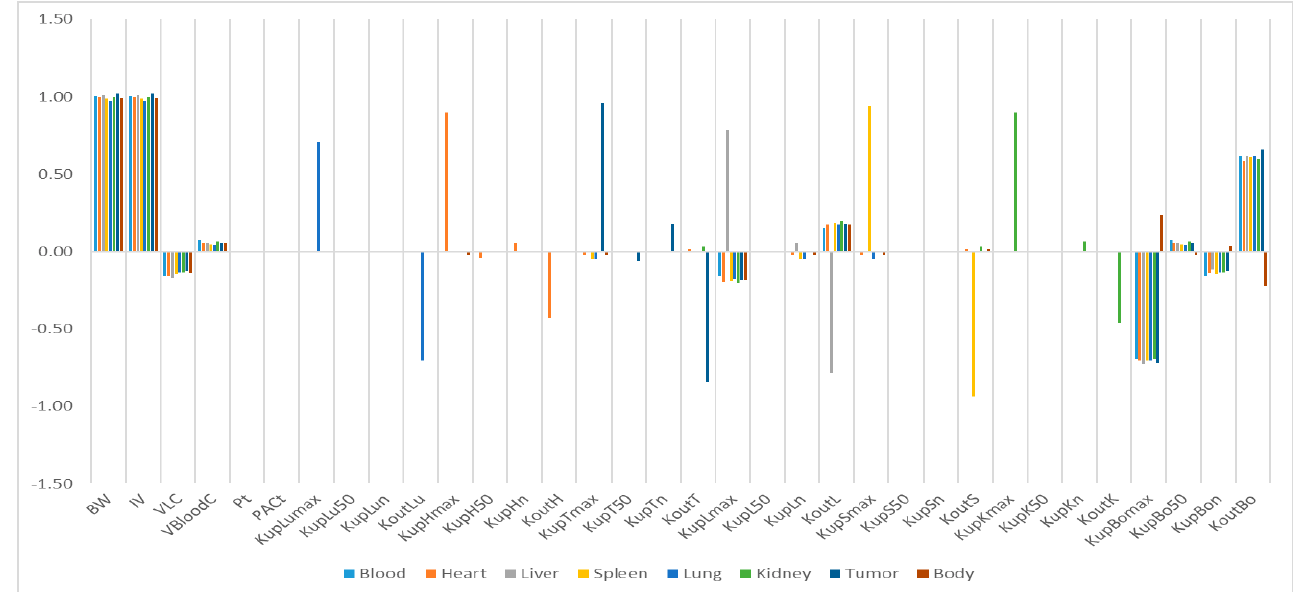
Figure 8. Relative sensitivity analyses for the parameters of mPEG5k-28.57%-80 nm NPs.